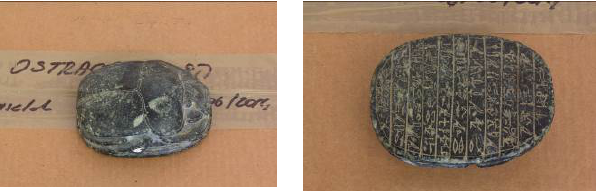
Figure 3. The heart scarab with the spell 30B of the Book of the Dead written of the lower